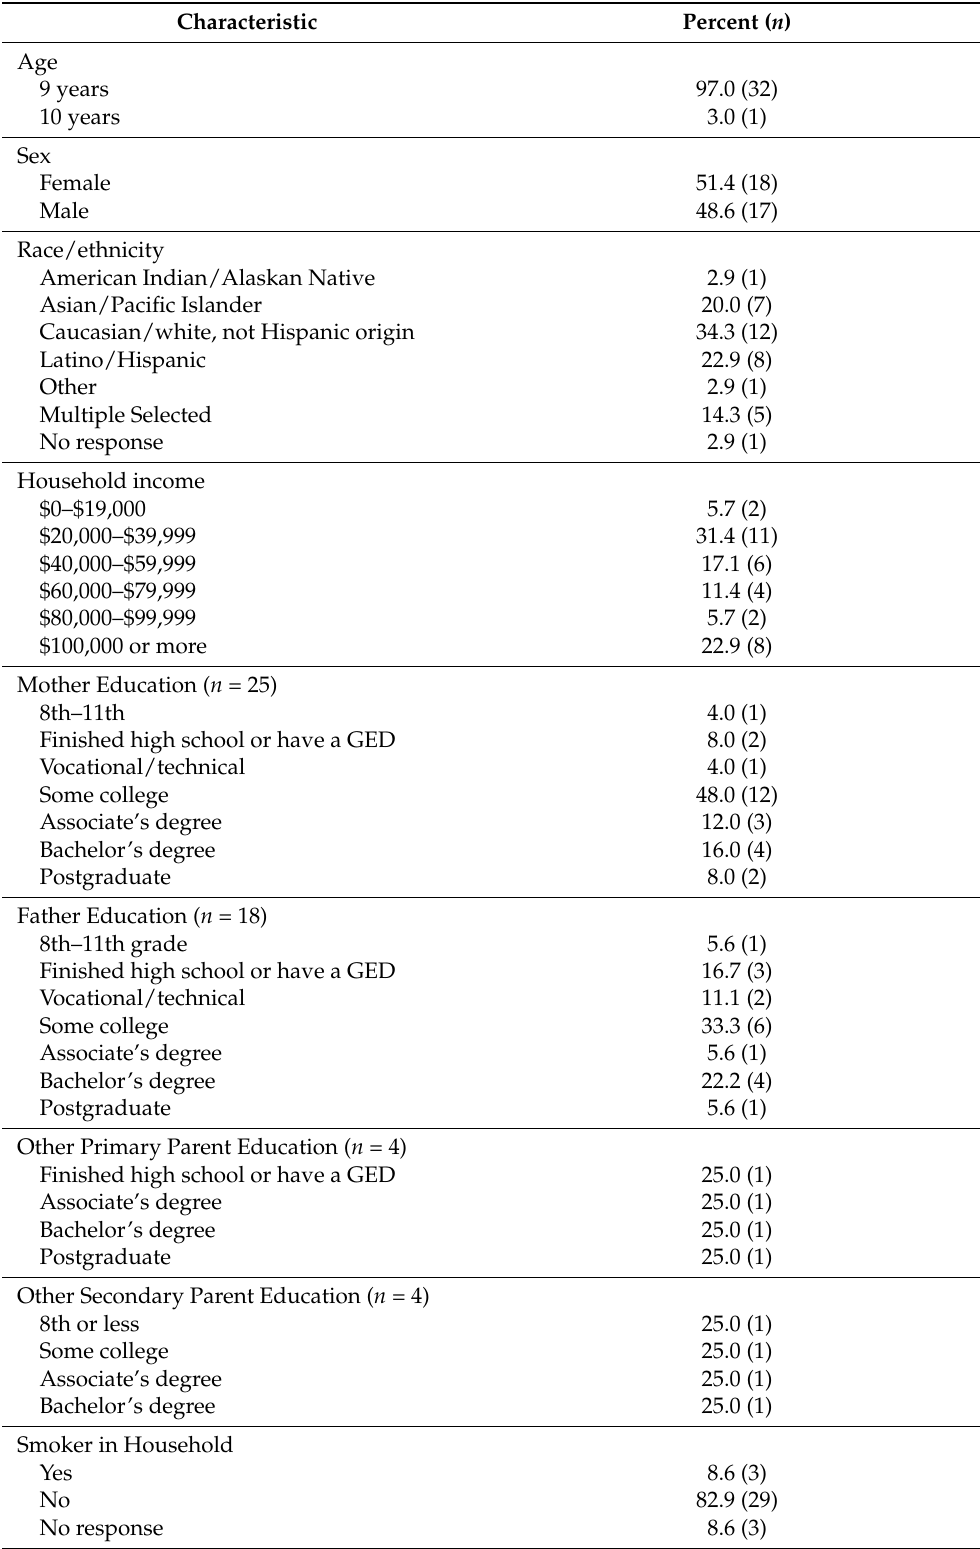
Table 1. Participant Characteristics at